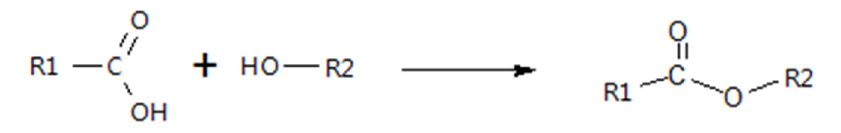
Figure 6. Esterification